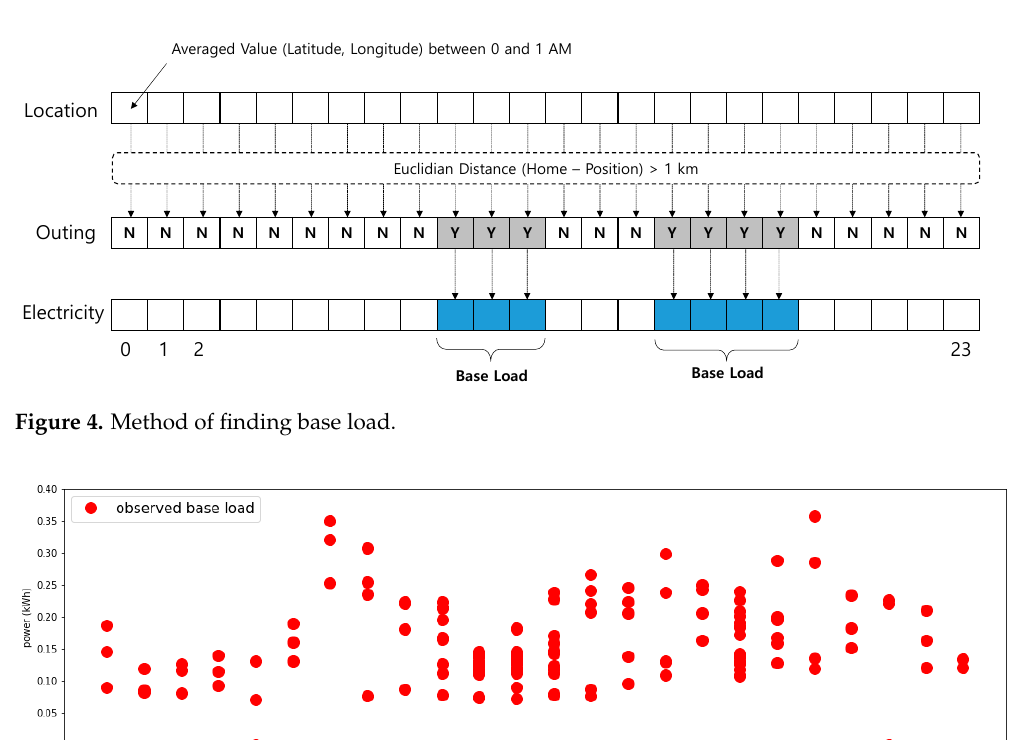
Figure 5. Sample user’s base load by time (raw data).